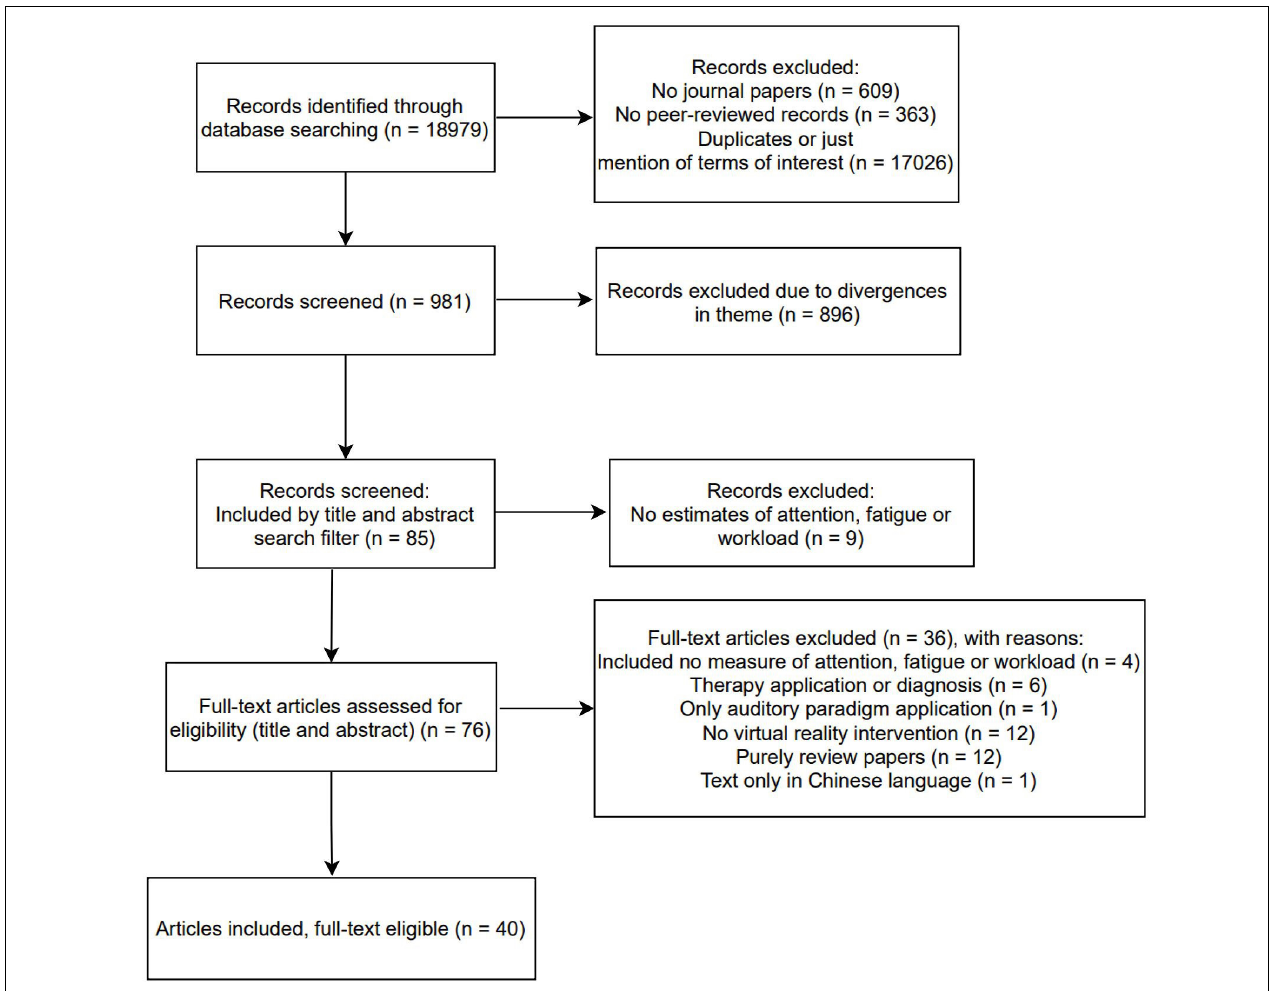
FIGURE 2 | PRISMA flow chart scoping attention allocation, virtual reality, cognitive workload and